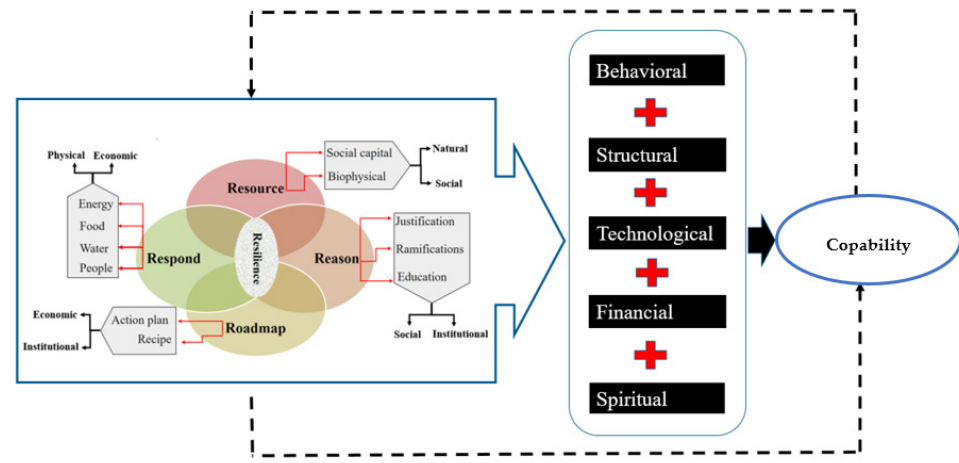
Figure 8. Comprehensive conceptual model (4R package) for disaster management and its connec- tion with resilience and